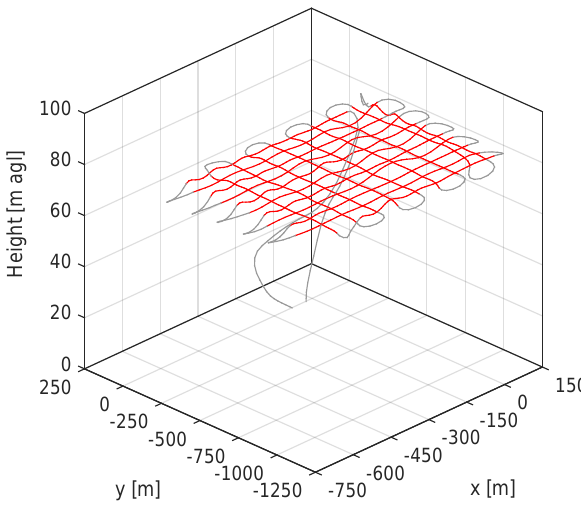
Figure 4. Typical flight pattern for the surface-temperature sur- veys during the BLLAST campaign. Data are only evaluated for the straight flight legs coloured in red, where the infrared sensor is assumed to look vertically